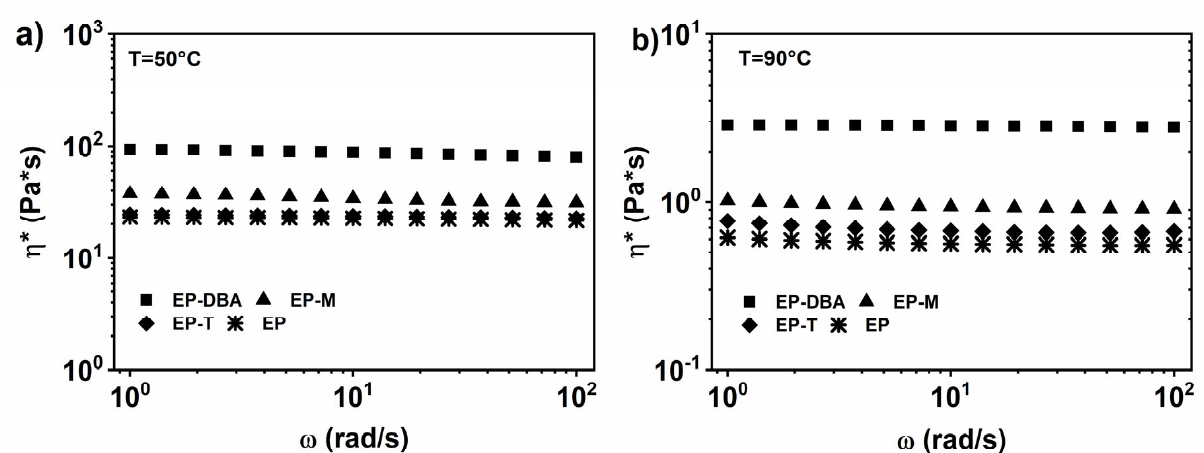
Figure 4. Complex viscosity ( η *) vs. frequency ( ω ) for the EP, EP-DBA, EP-M and EP-T epoxy mixtures, at: ( a ) T = 50 °C; ( b ) T = 90 °C.